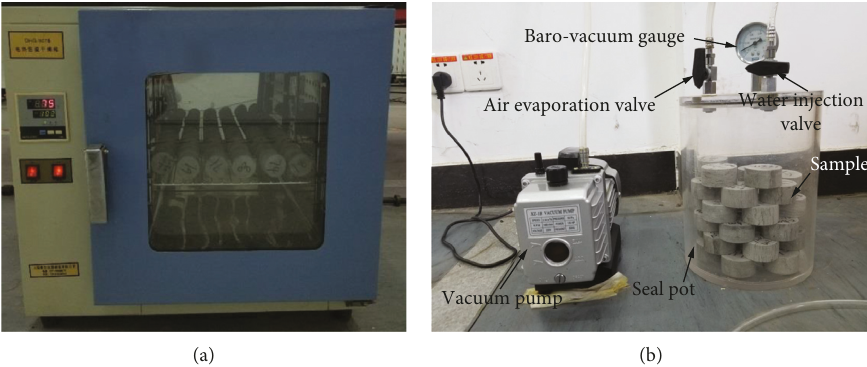
Figure 1: Specimen saturation system: (a) electrothermal drying oven; (b) negative pressure vacuum pumping system.